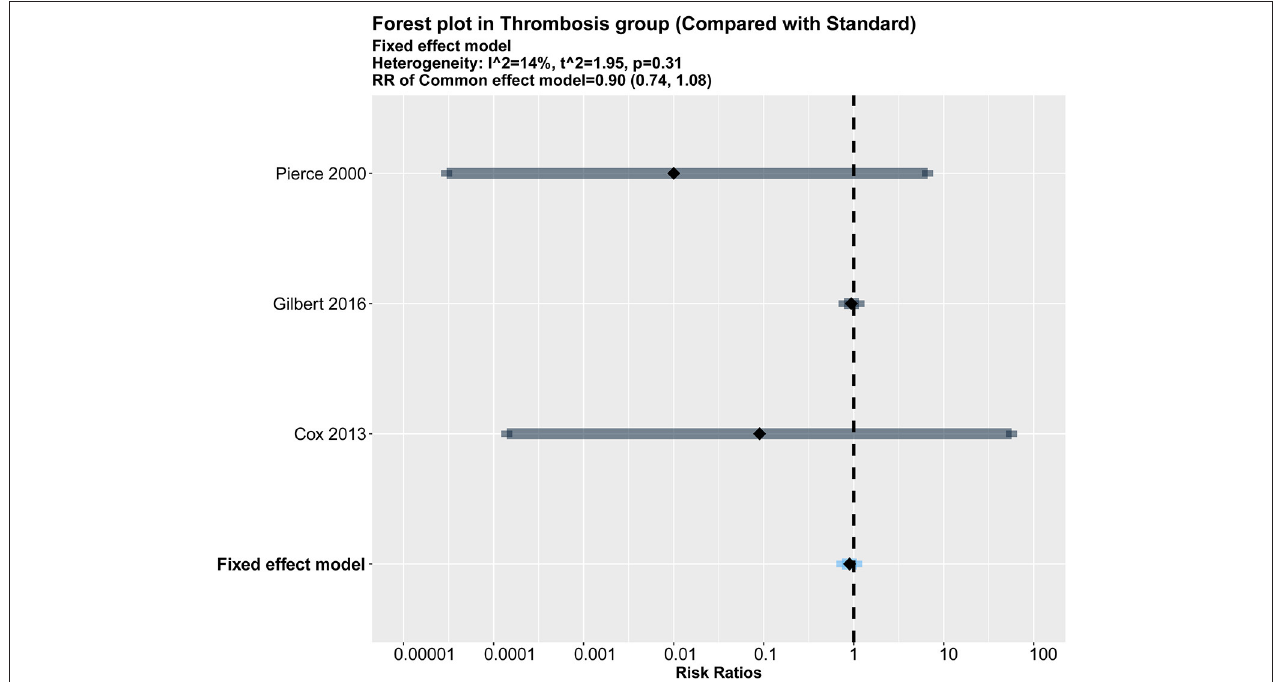
FIGURE 6 | Forest plot of the risk of thrombosis for impregnated catheters.